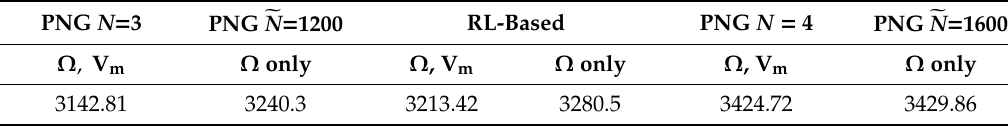
Table 4. Energy consumption for each guidance